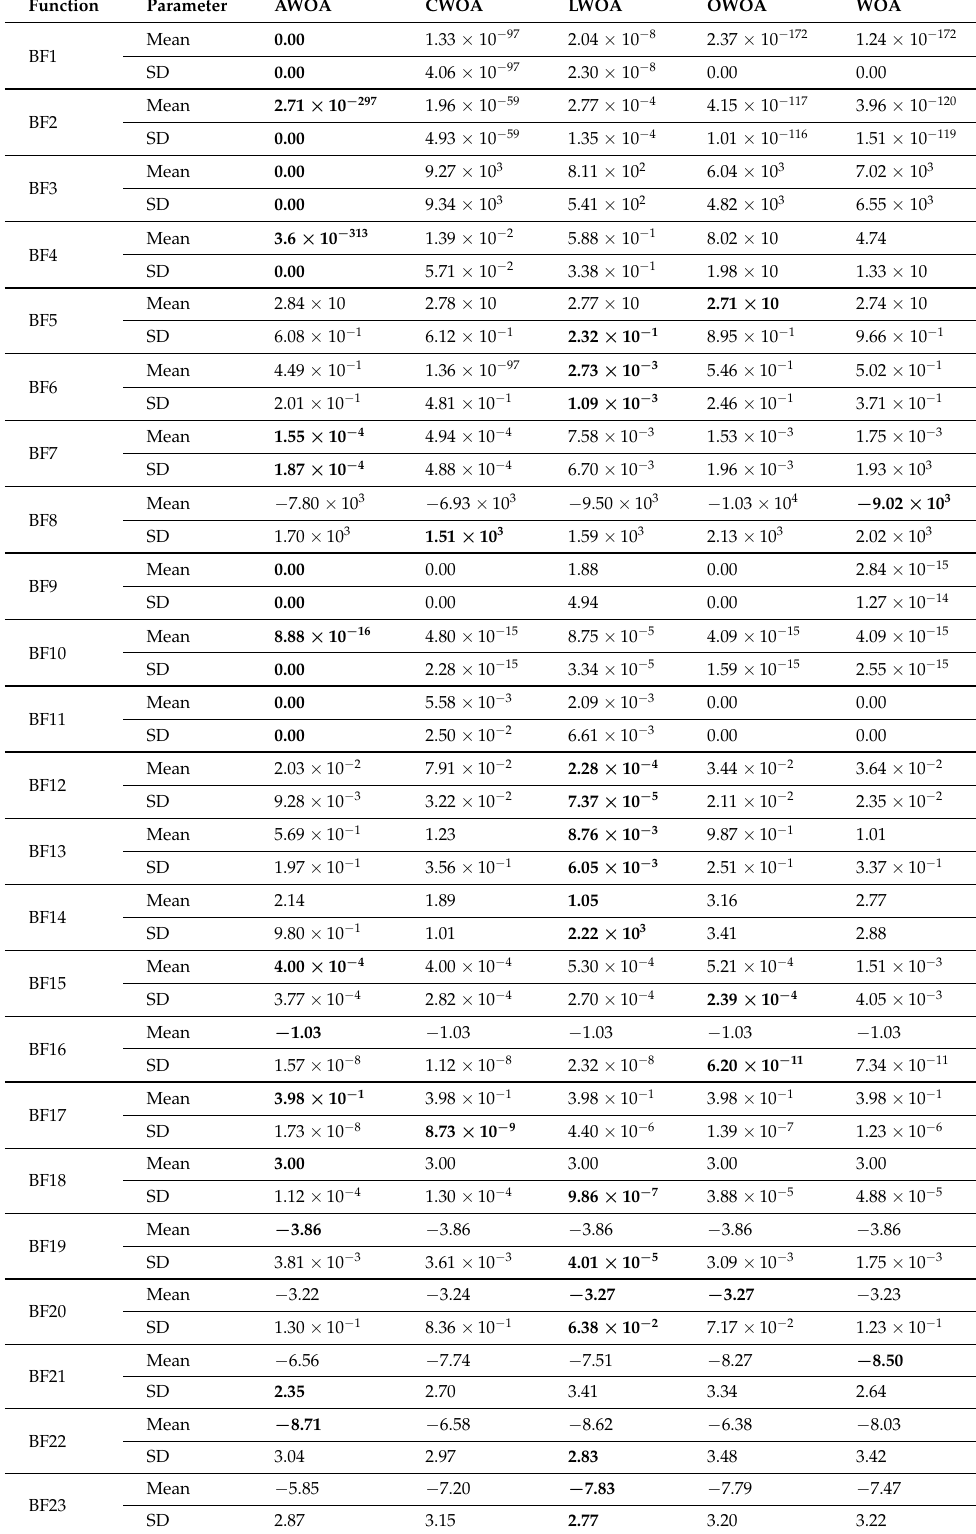
Table 3. Results of Benchmark